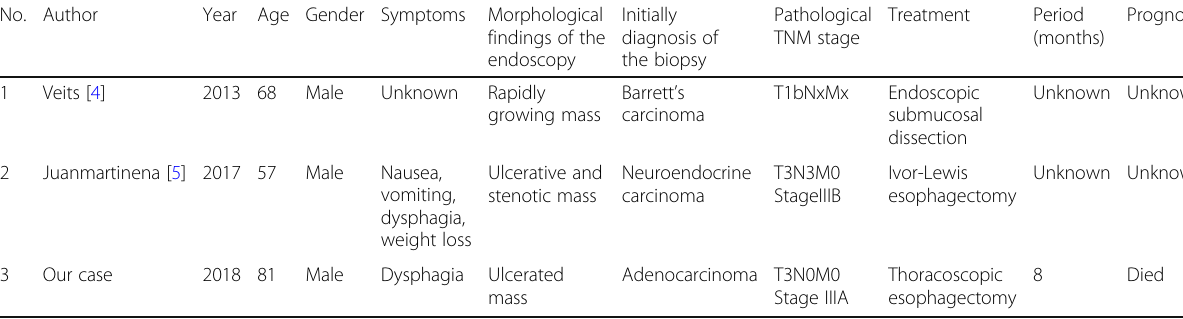
Table 1 Cases of mixed adenoneuroendocrine carcinoma of the esophagogastric junction No. Author